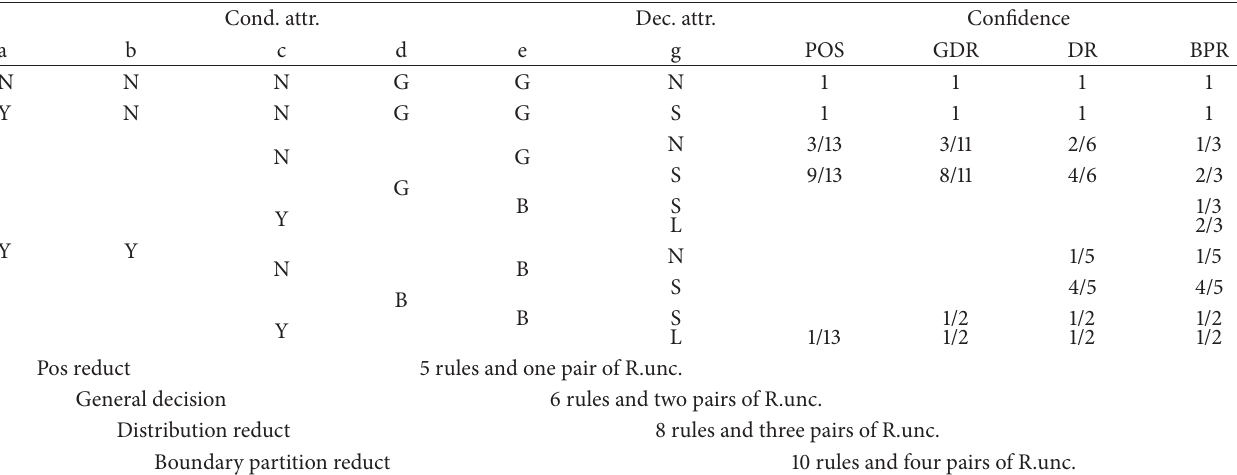
Table 4: The rules description of five reductions. Cond.